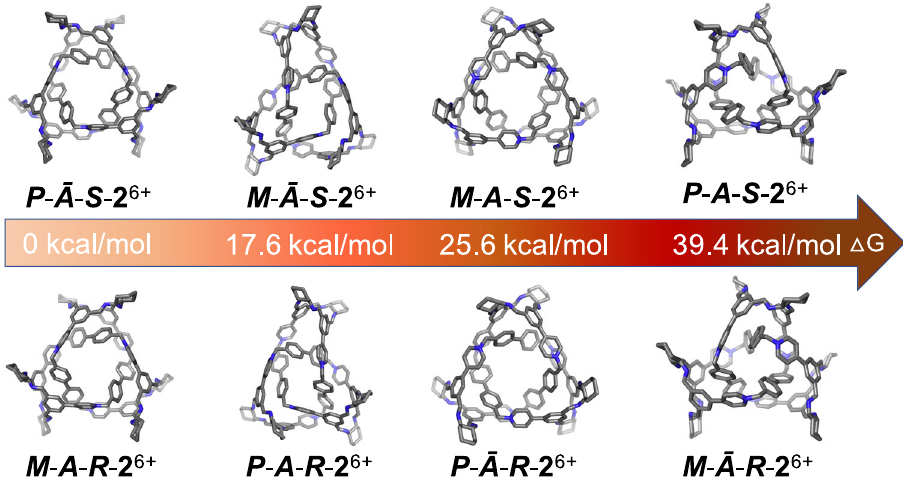
Fig. 5 Optimized structures of different possible conformational diastereomers of S -2 6 + (top) and R -2 6 + (bottom) with the relative free energies. The calculation was performed by using DFT calculations at the level of BP86-D3 functional and 6-311G(d) basis set. The result indicates that P - ᾹᾹ - S - 2 6 + and its enantiomer namely M - A - S - 2 6 + are the most favored products among the diastereomers of R - 2 6 + and S - 2 6 +